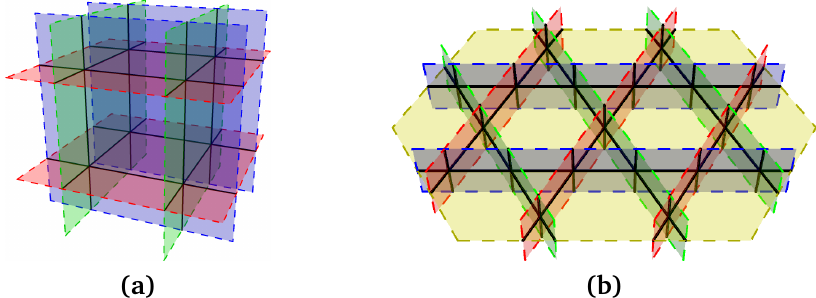
Figure 1: (a) A foliation structure consisting of three stacks of layers (red, green, and blue), which are often referred to as leaves. In the coarse-grained continuum limit, we will think of the layers as being infinitesimally close to each other. If the layers have a finite separation, then the intersections of the layers results in a cubic lattice. (b) A foliation structure consisting of four stacks of layers (red, green, blue, and yellow), which results in a stack of kagome lattices when the layers have finite